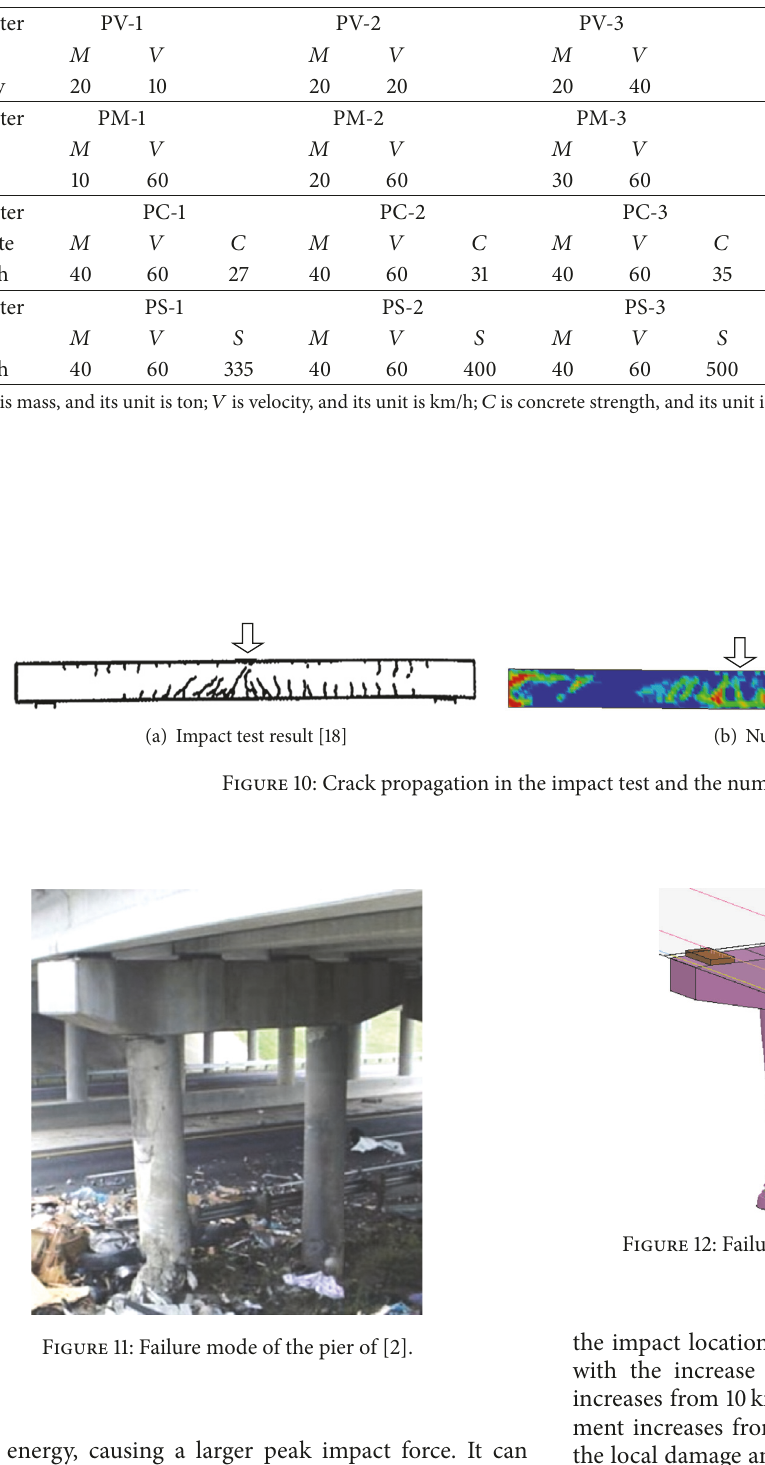
Table 7: Vehicle impact cases.